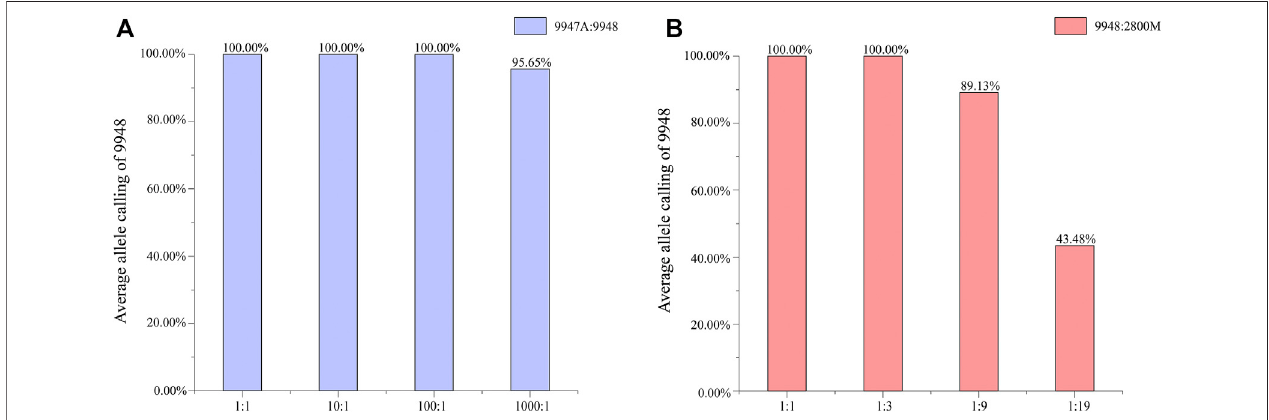
FIGURE 3 | (A) Average allele calling ratio for different male/female mixtures. (B) The average allele calling ratio for different male/male